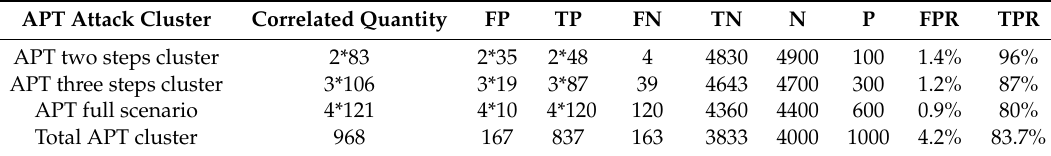
Table 5. Evaluation AICM module correlation